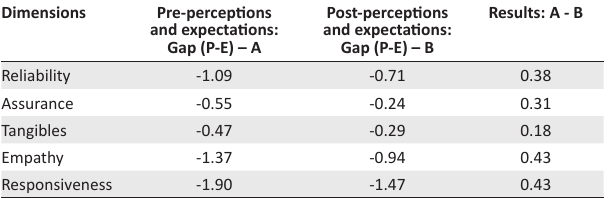
TABLE 4: SERVQUAL gap scores between perceptions and expectations: Gap scores. Dimensions